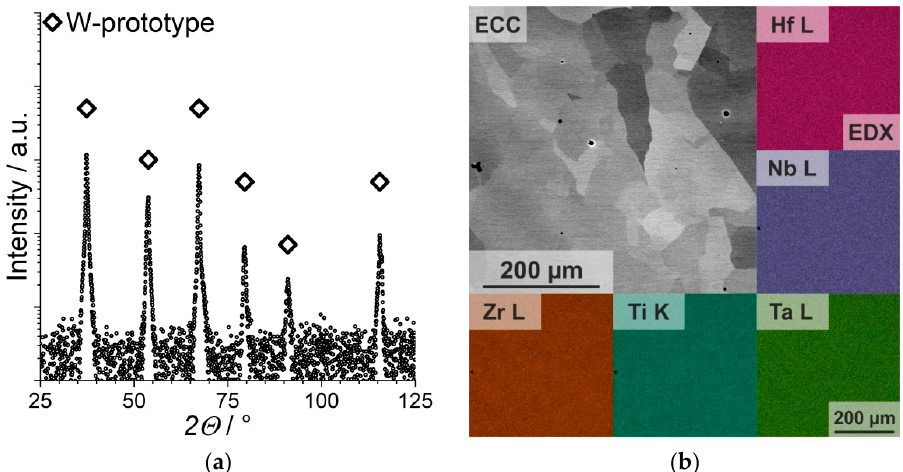
Figure 1. Microstructural investigations of HfNbTaTiZr: ( a ) X-ray diffraction (XRD) pattern; diamond-shaped symbols highlight peaks of the body centered cubic (bcc) phase (W prototype). Intensity is plotted in a logarithmic scale for better visibility of low-intensity peaks. ( b ) electron channeling contrast imaging (ECC) micrograph and elemental energy-dispersive X-ray spectroscopy (EDX) maps of the same area.